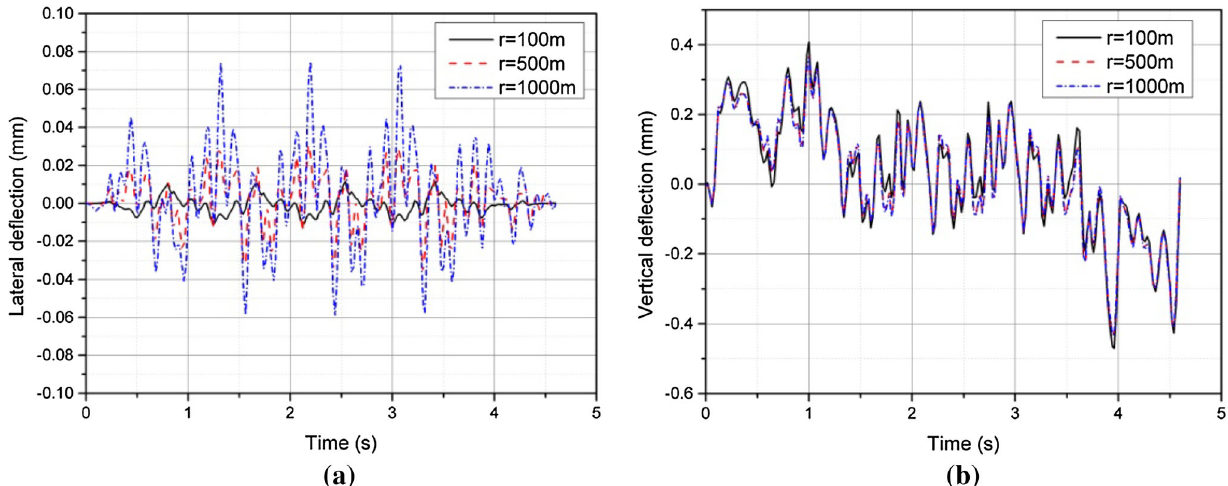
Fig. 7 Record of vibration amplitude at middle span (unit: mm). a Lateral, b